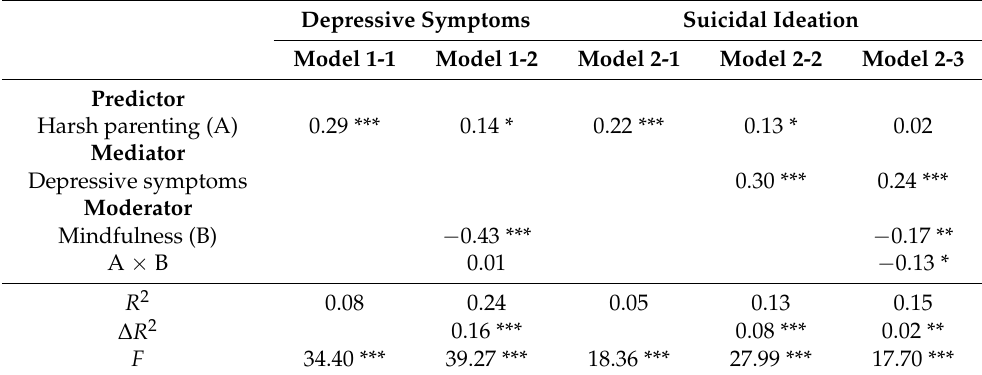
Table 2. Results of hierarchical regression analysis.